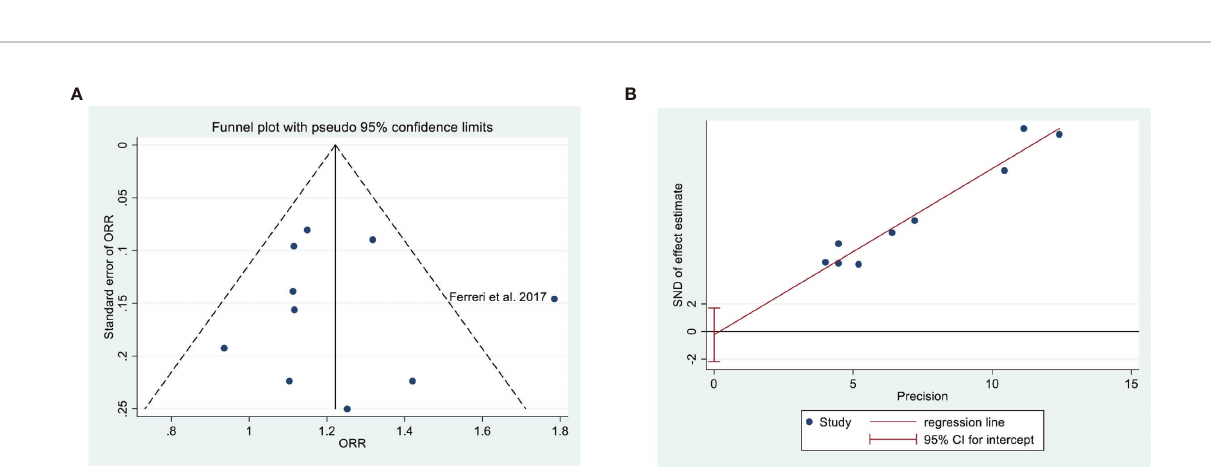
FIGURE 4 | Assessment of publication bias in overall response rate based on a funnel plot (A) and Egger ’ s test ( B , P =